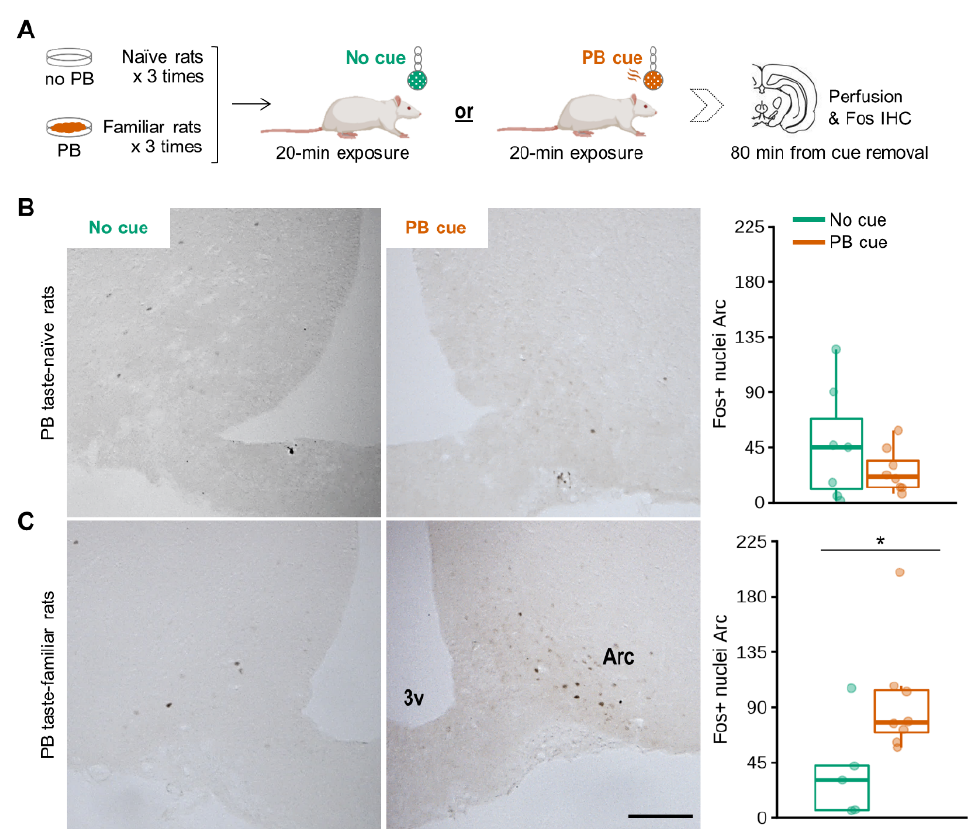
Figure 3. Olfactory detection of PB activates cells in the Arc in non-food-deprived PB-taste familiar rats. ( A ) Schematic of the experimental design in the home cage. Representative images showing effects of exposure to a 20-min olfactory PB cue to increase the number of cells detected that express Fos protein in the Arc, together with the corresponding unilateral manual counting of Fos+ nuclei in ( B ) PB taste-naïve rats ( n = 15: No cue, n = 7; PB cue, n = 8) and ( C ) PB taste-familiar rats ( n = 13: No cue, n = 5; PB cue, n = 8). Arc, arcuate nucleus; 3v, third ventricle. Bregma: − 2.40 mm; scale bar = 200 μ m (applies to all four images). For illustration, the thick line always corresponds to the median, boxes show first and third quartiles and whiskers represent minimum and maximum values. Symbols indicate differences between the control and the PB cue conditions at (*) p < 0.05 by two-way repeated measures ANOVA with further one-way ANOVA upon data split according to Conditioning [naïve, familiar]. PB; peanut butter.